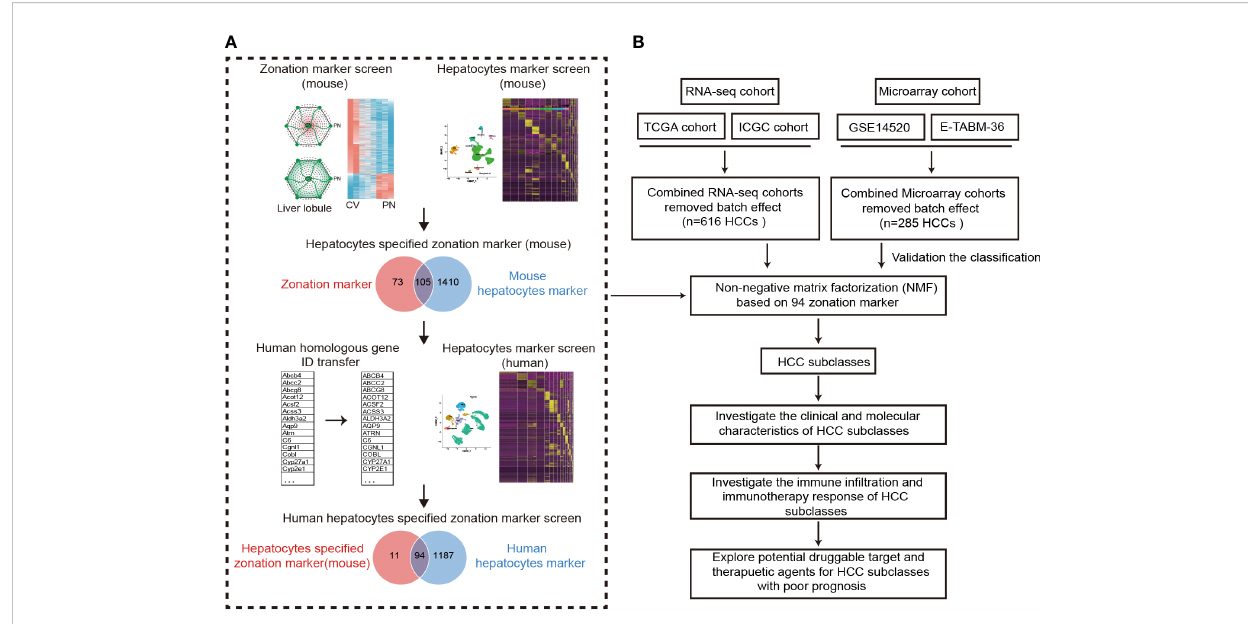
FIGURE 1 Design overview. (A) The procedure of the identi fi cation of hepatocyte-speci fi ed zonation markers. (B) The fl owchart of the study. ICGC, International Cancer Genome Consortium; TCGA, The Cancer Genome Atlas; HCC, Hepatocellular